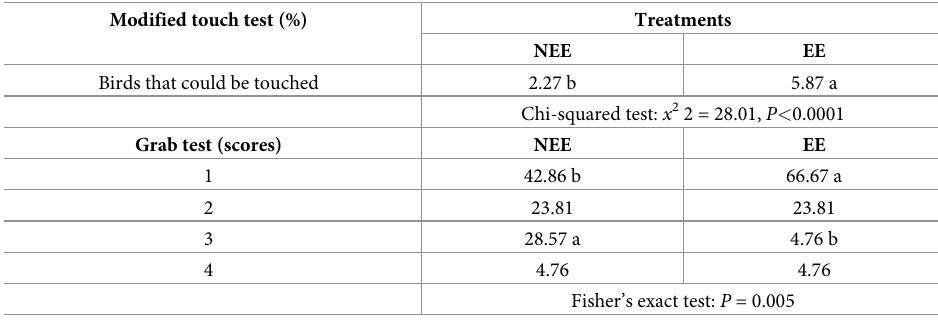
Table 5. Frequencies of the modified touch test and of scores in the grab test of broiler chickens housed in envi- ronments with and without enrichment at 42 days. Modified touch test (%) Birds that could be